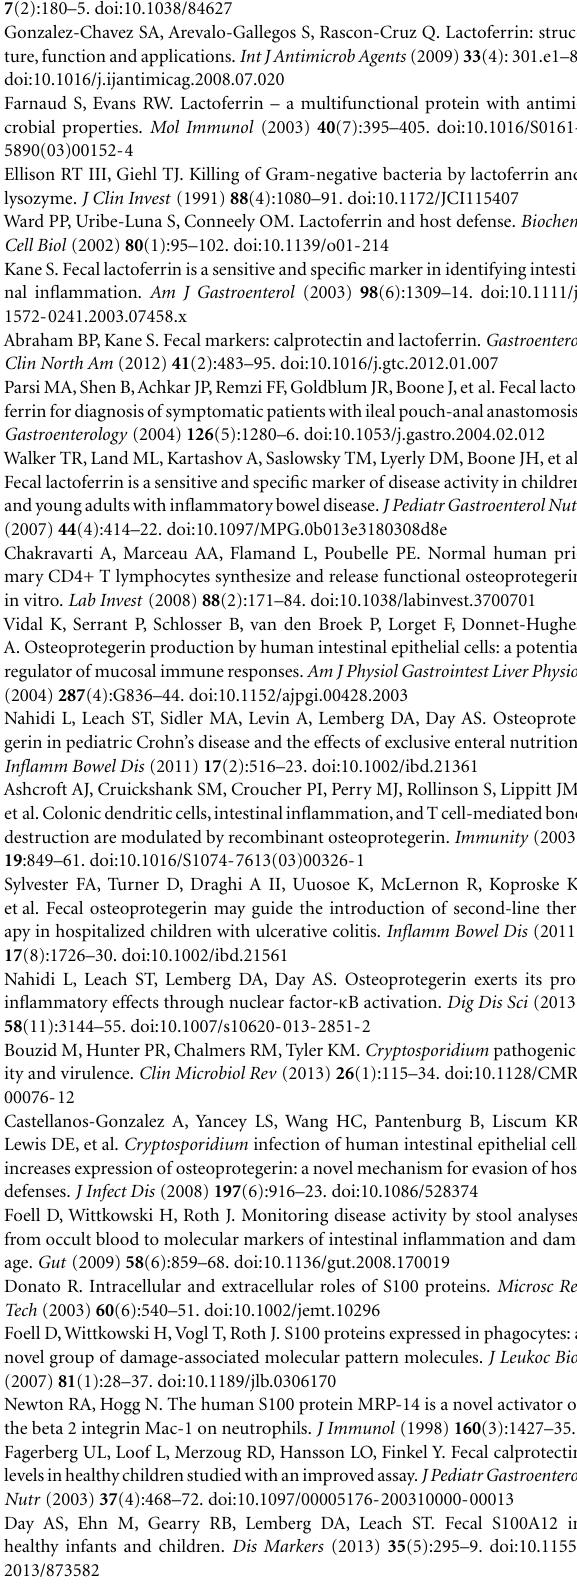
tablebowel syndromeon RomeIIIcriteria:amulticenter study. JGastroenterol Hepatol (2012) 27 (4):760–5.